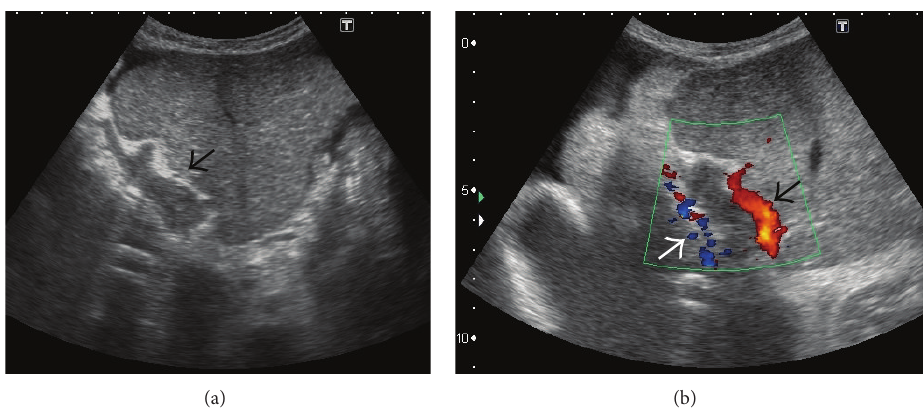
Figure 33: Gray-scale US image showing thrombosed left portal vein (arrow in (a)). On application of colour Doppler (b), hypertrophy of the accompanying branch of hepatic artery can be seen (black arrow in (b)) with opening up of periportal collateral venous channels (white